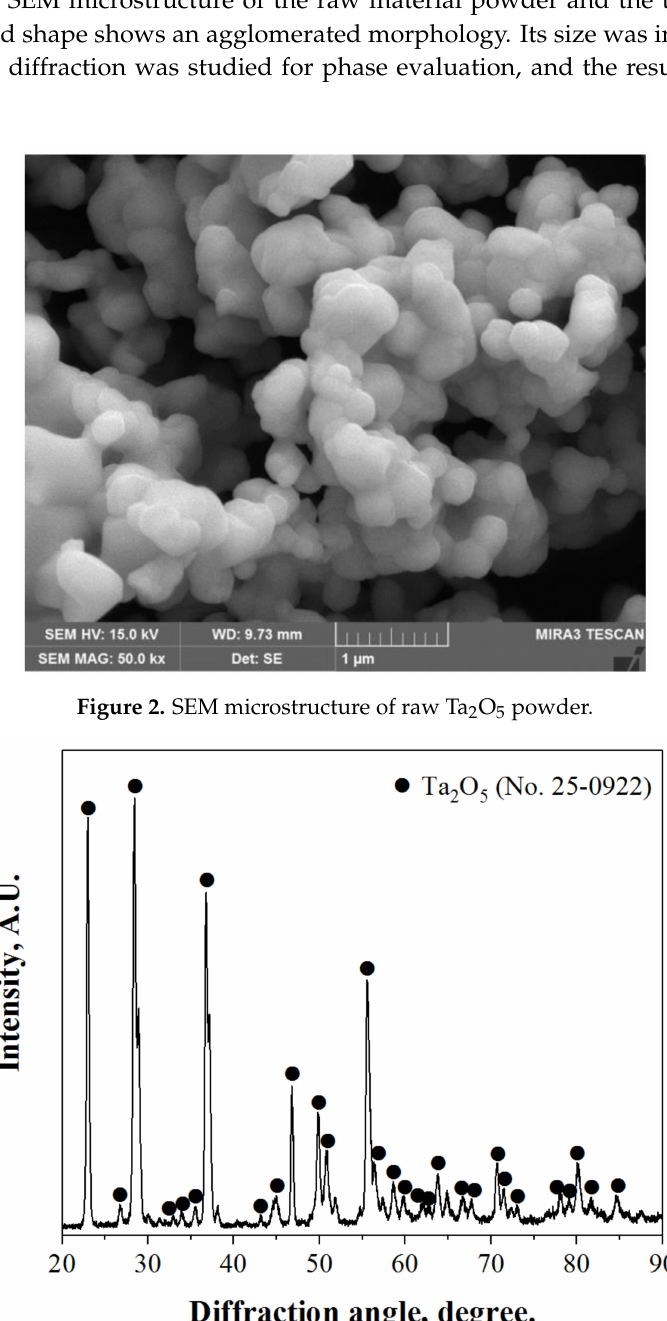
Figure 3. X-ray diffraction patterns measured in the raw Ta 2 O 5